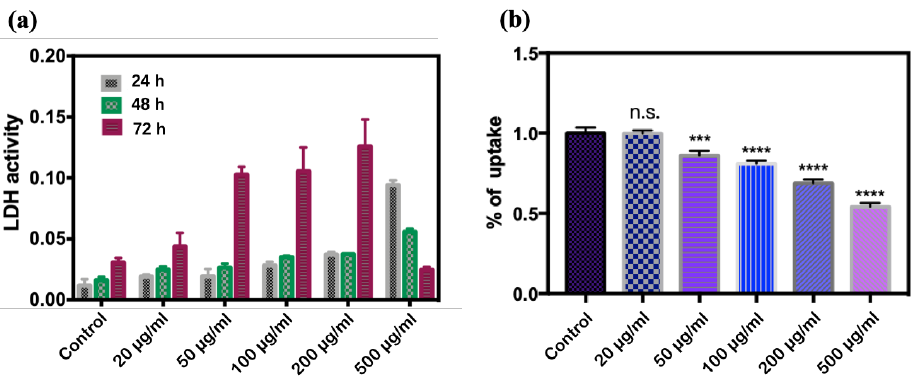
Figure 5. Effect of CQDs on the E. coli membrane. ( a ) The amount of LDH released by E. coli at different CQDs concentrations; ( b ) the uptake rate of crystal violet (n.s. p > 0.05, *** p < 0.001 and **** p < 0.0001).